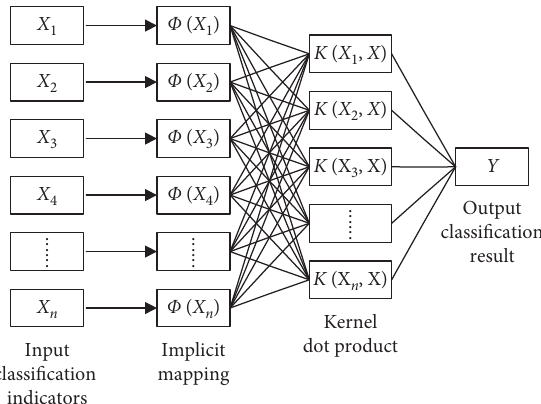
Figure 1: Implicit mapping model expressed by